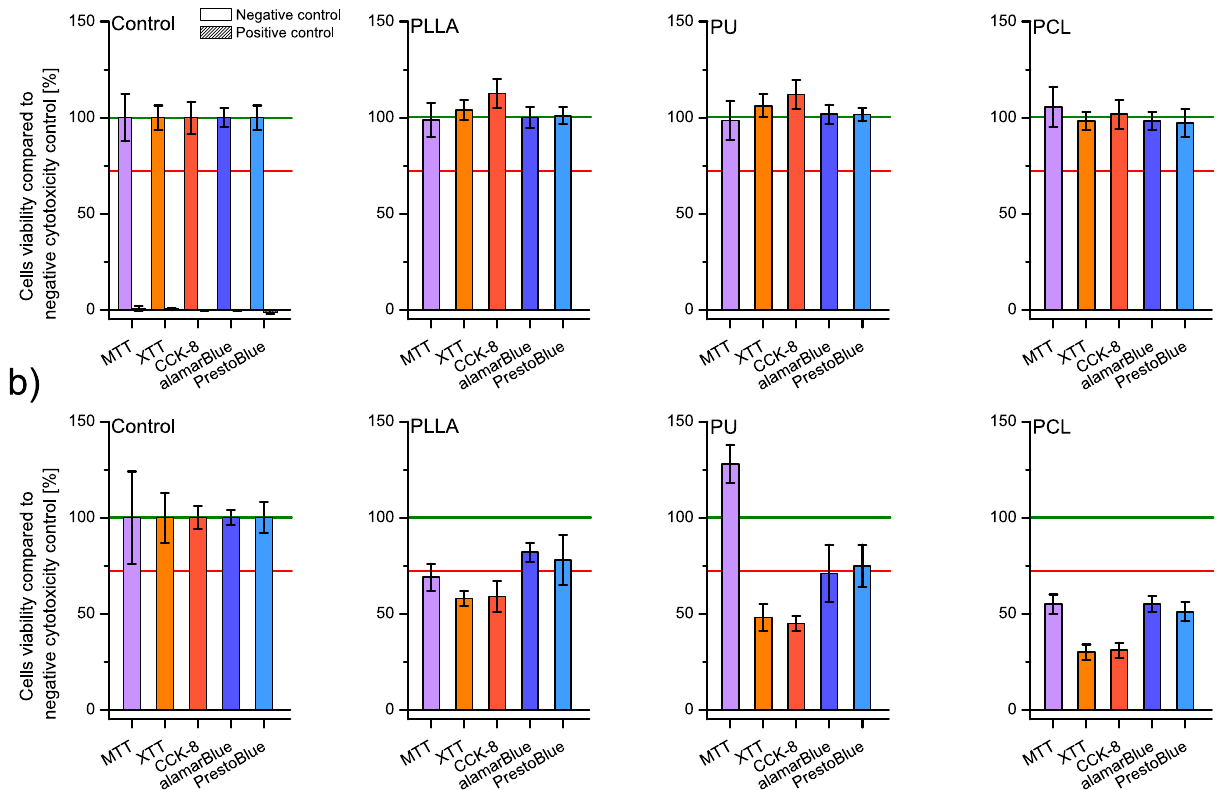
Figure 2. Cells viability was tested by MTT, XTT, CCK-8, alamarBlue, and PrestoBlue assays ( a ) on scaffolds’ liquid extracts after 24 h of incubation with PLLA, PU, and PCL; and ( b ) after 24 h of direct culture on PLLA, PU, and PCL scaffolds; including controls. In every graph, the green line represents the negative control result, and a red line represents the threshold for cytotoxicity level of 70% of cells viability compared to the negative